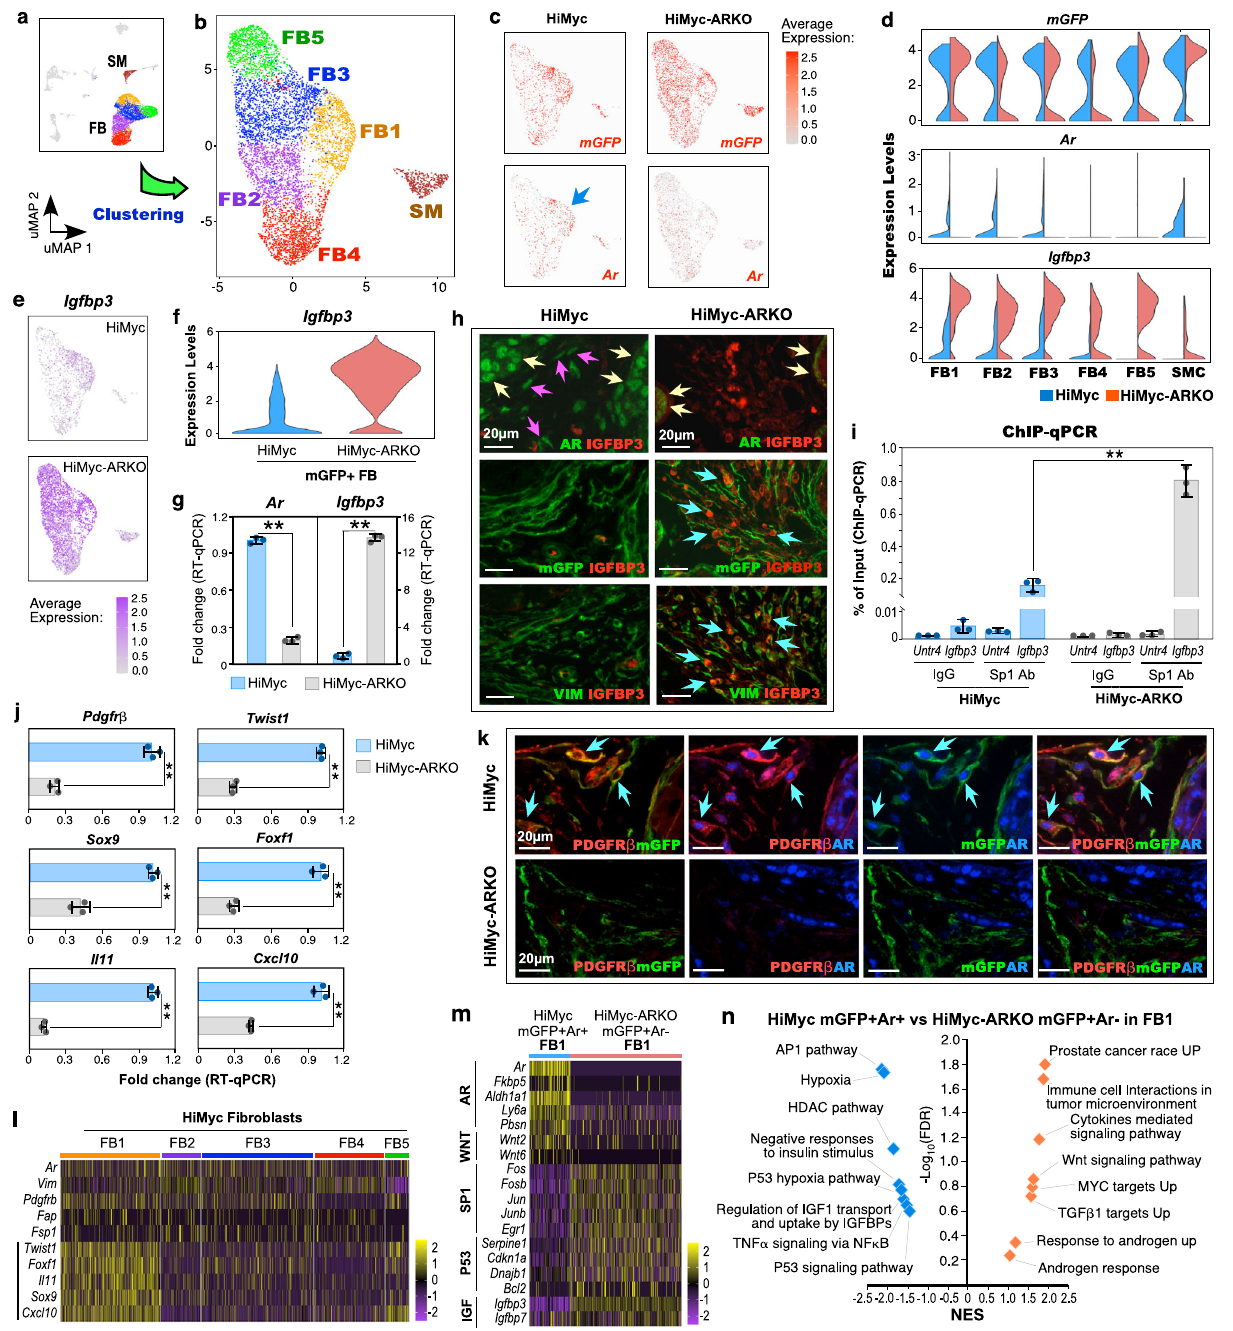
Fig. 5 | Identifying AR loss-induced molecular changes in Gli1-lineage stromal cells. a – b UMAP plots of stromal fi broblast (FB) and smooth muscle (SM) cell clusters from Hi-Myc:R26 mTmG/+ :Gli1 CreER/+ and Hi-Myc:R26 mTmG/+ :Ar L/Y :Gli1 CreER/+ . c Gene expressionlevelsof mGFP and Ar inUMAPplotsseparatedbyindicatedgenotypes. Color intensity indicates the scaled expression level in each cell. Blue arrow indi- cates Ar -expressing cells from FB1 in Hi-Myc:R26 mTmG/+ :Gli1 CreER/+ . d Violin plots visualizing the expressionlevels of mGFP , Ar , and insulin-like growthfactorbinding protein 3 ( Igfbp3 ) in stromal clusters of each genotype. e Gene expression levels of Igfbp3 inUMAPplotsofstromalFBandSMcells.Colorintensityindicatesthescaled expression level in each cell. f Violin plots of mGFP + FB cells. g qPCR analysis of Ar and Igfbp3 expression shown as fold change in FACs-sorted mGFP + cells from prostatetissuesofindicatedgenotypes. h Co-localizationofIGFBP3witheitherAR, mGFP, or Vimentin (Vim) from indicated prostate tissues. Yellow and pink arrows indicate AR + epithelial and stromal cell, respectively. Blue arrows indicate IGFBP3 + stromal cells co-expressing with either mGFP or Vim. Scale bars, 20 μ m. i Sp1